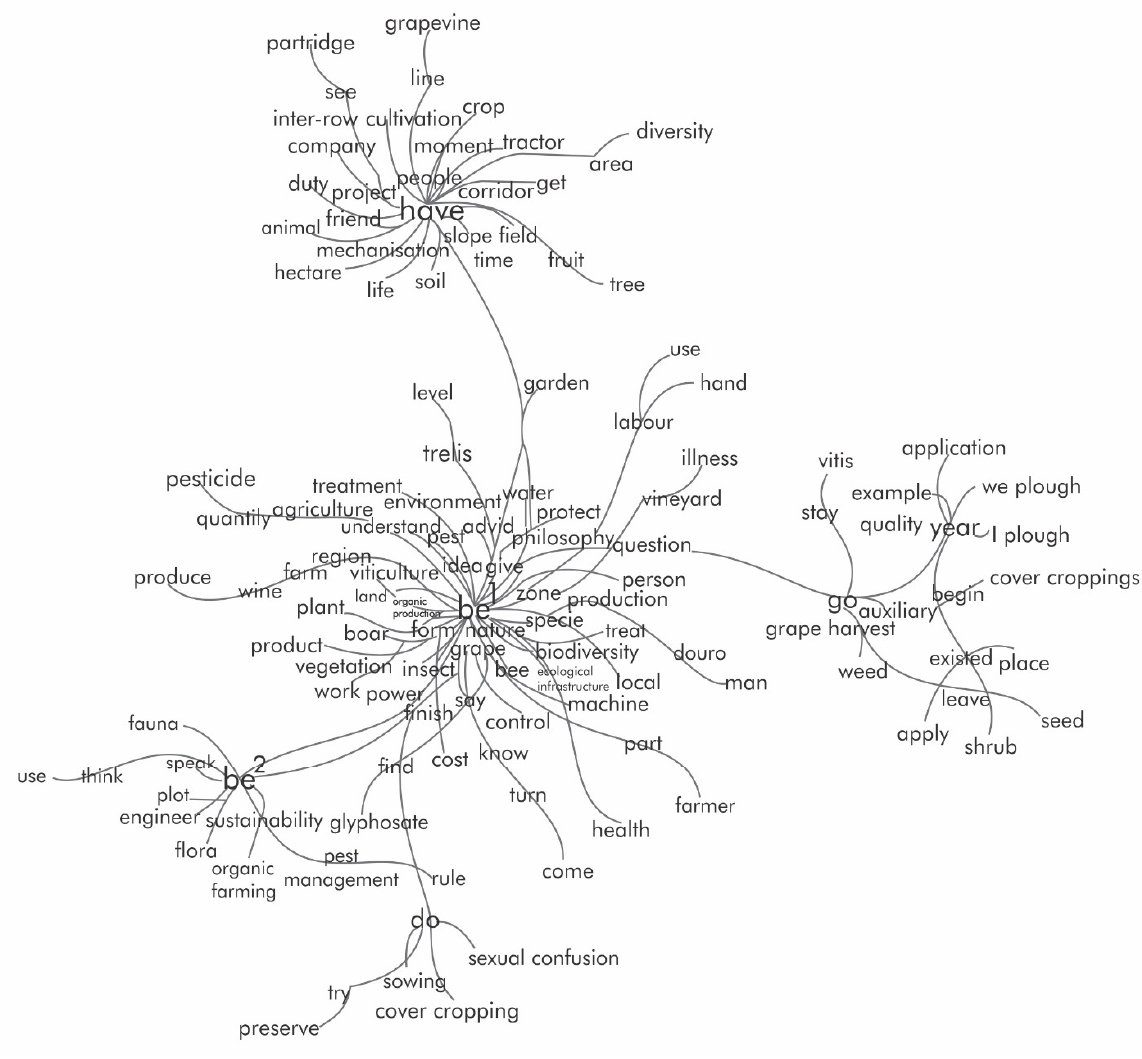
Figure 2. Co-occurrence between words. Source: research data analysed by the Iramuteq software